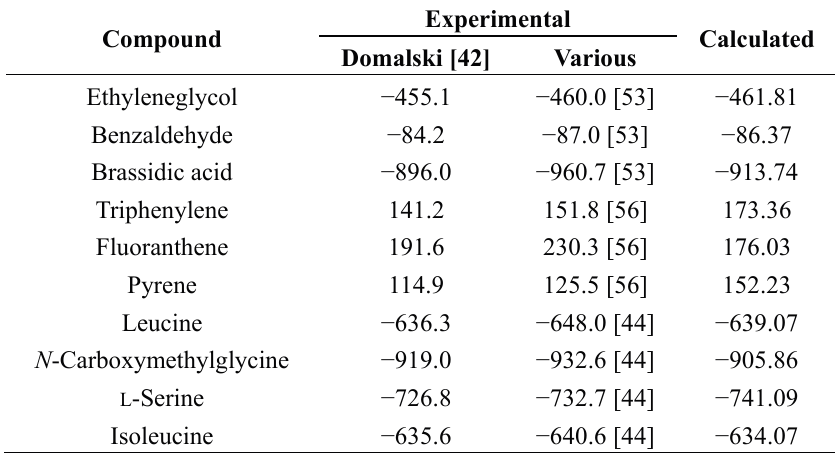
Table 5. Heat of Formation: Experiment vs. Calculation (in kJ/mol).